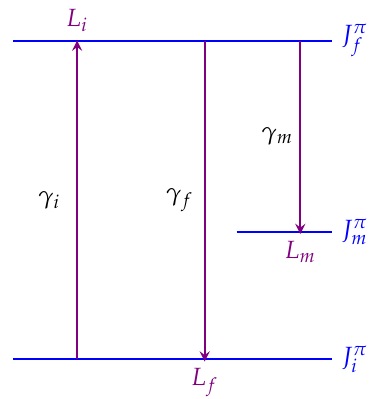
Figure 1. Level diagram of an nuclear resonance fluorescence (NRF) process. γ i is the absorption line, while the emission line may only be γ f or γ f and its branching to a low-lying level γ m . L i , L f , and L m are the multipolarities associated with the